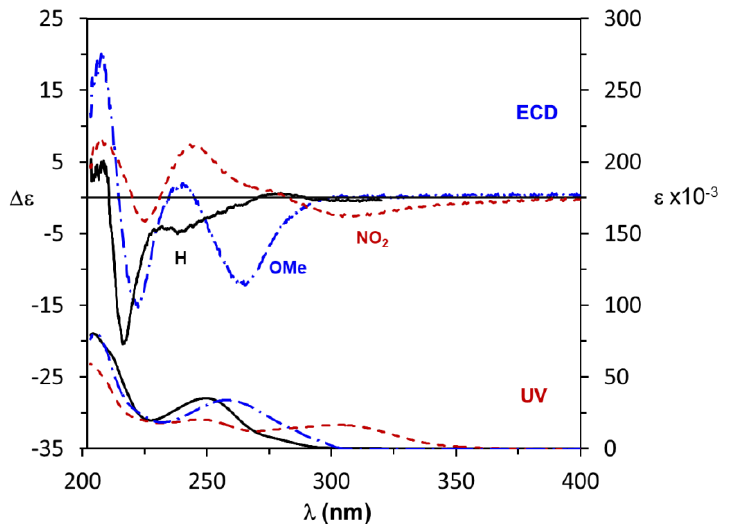
Figure 8. UV and ECD spectra of the biphenylamides ( R )- 4da (solid black line), ( R )- 4db (dashed dotted blue line) and ( R )- 4dc (dashed red line).